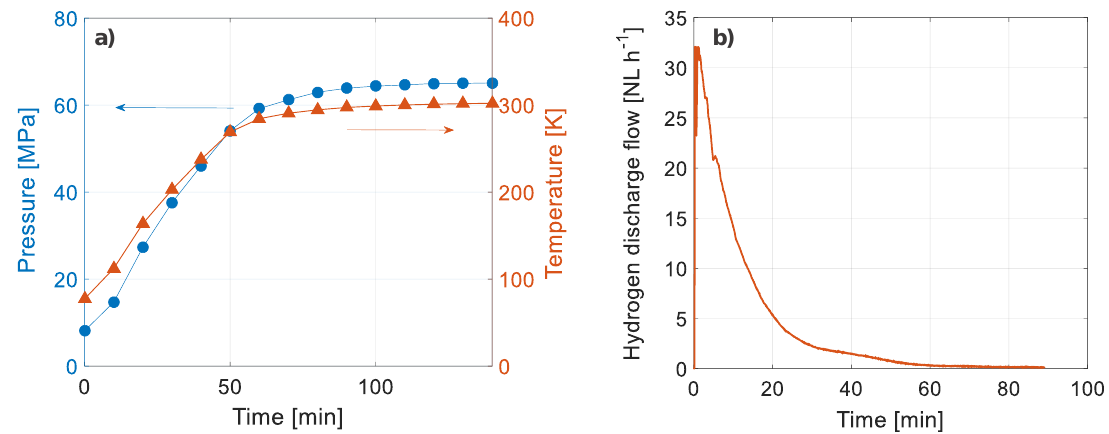
Figure 10. ( a ) Time evolution of pressure and temperature in an adsorption–desorption compressor and; ( b ) high-pressure hydrogen flow produced by the adsorption–desorption compressor (charging pressure = 8 MPa, V = 0.5 L, amount of adsorbent = 0.175 kg).